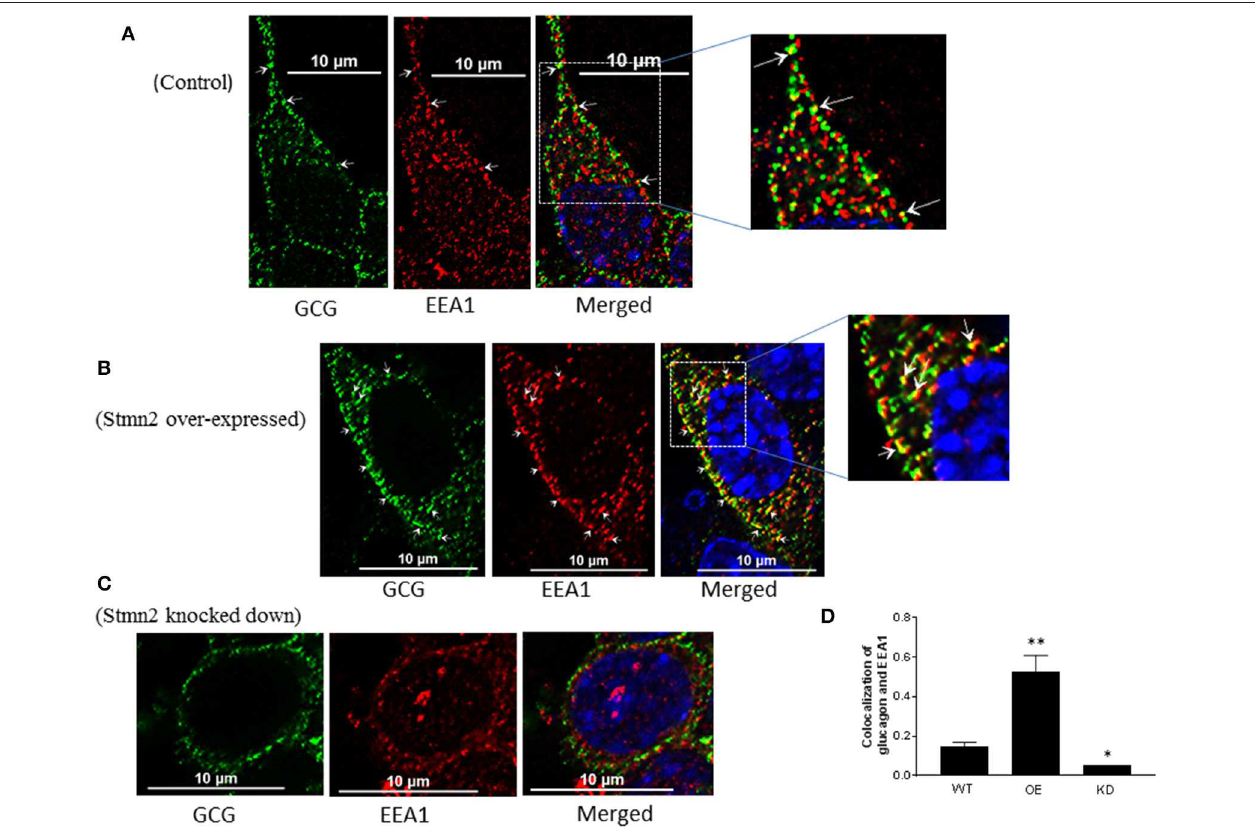
FIGURE 5 | Stathmin-2 modulates glucagon trafficking through early endosomes. After transfection with either empty vector (A) , vector encoding Stmn2 (B) or siRNAs against Stmn2 (C) , α TC1-6 cells were immunostained using primary antibodies against glucagon and the early endosome marker EEA1. Images were acquired and analyzed for co-localization as described in Figure 1 . Colocalization of glucagon and EEA1 (yellow puncta) are indicated by arrows in wt cells (A) or arrowheads in cells overexpressing Stmn2 (B) . (D) Level of colocalization between glucagon and EEA1 was determined by Pearson’s correlation coefficient in wt cells, cells in which Stmn2 was overexpressed (OE) and in which Stmn2 was knocked down by siRNA (KD). Values were expressed as mean ± SEM ( n = 5) and compared by 1-Way ANOVA. * p < 0.05; ** < 0.001 compared to